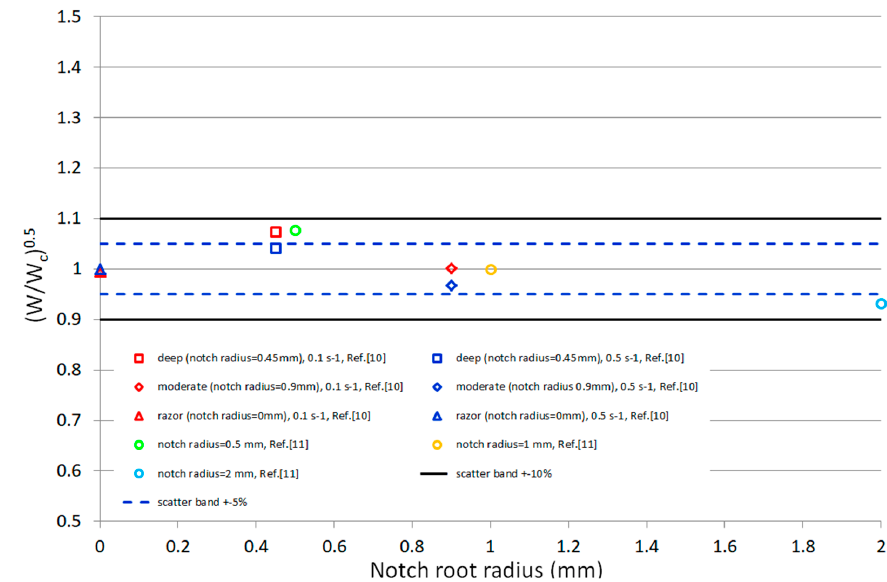
Figure 7. Synthesis of fracture data in terms of normalized SED. The data from reference [10] are labeled in the legend reporting the geometry followed by the strain rate, while the data from reference [11] report the notch radius in the legend.